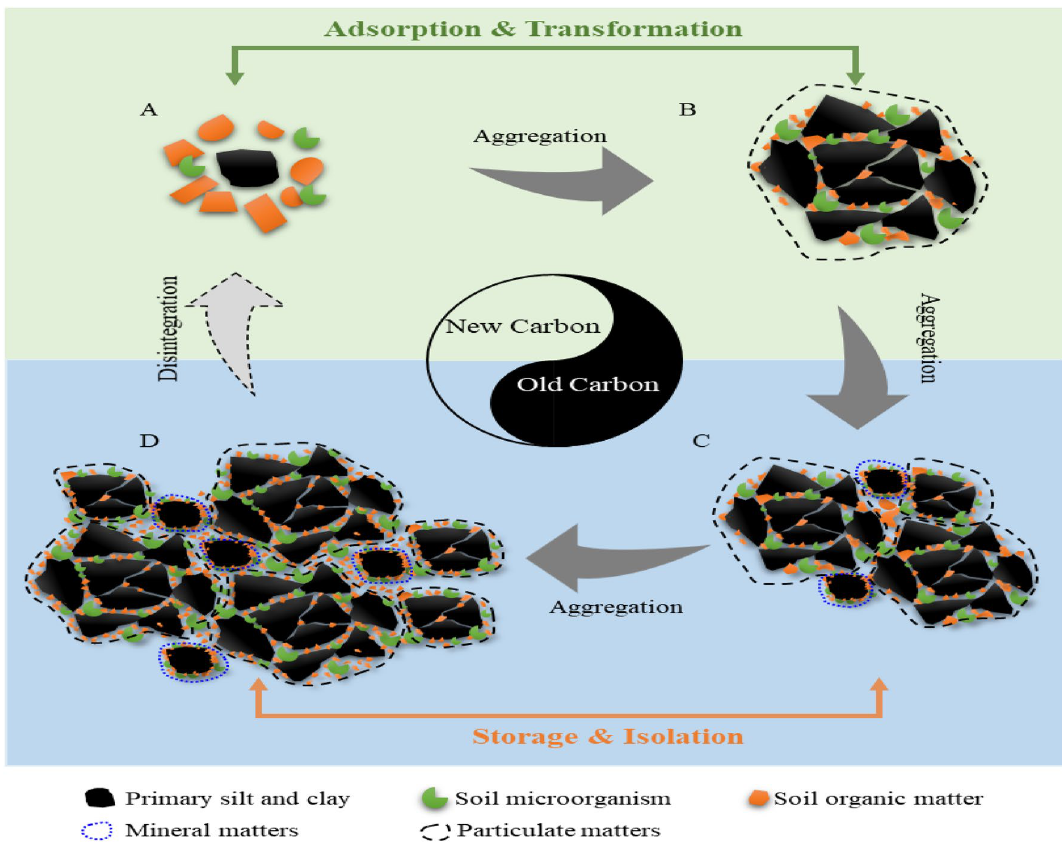
Figure 6. Schematic overview of soil aggregation process and organic C accumulation mechanisms in aggregates. ( A – D ) indicate silt + clay fraction (< 53 μm), micro-aggregate (53–250 μm), small macro-aggregate (250–2000 μm) and large macro-aggregate (> 2000 μm),